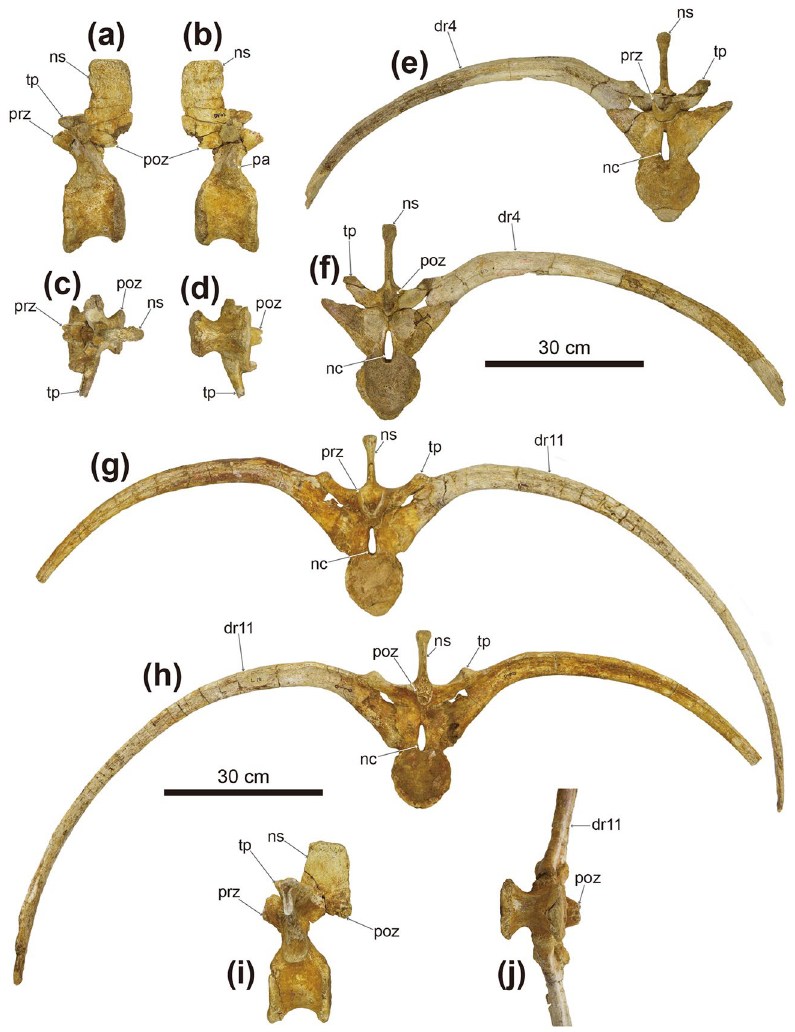
Figure 4. Photographs of dorsal vertebrae of Tarchia tumanovae sp. nov. (MPC-D 100/1353). The fourth dorsal vertebra in ( a ) left lateral, ( b ) right lateral, ( c ) dorsal, and ( d ) ventral views. Fourth dorsal vertebra with fused right rib in ( e ) anterior and ( f ) posterior views. The eleventh dorsal vertebra in ( g ) anterior, ( h ) posterior, ( i ) left lateral (with no ribs attached), and ( j ) ventral views. dr dorsal rib, nc neural canal, ns neural spine, pa parapophysis; prezygapophysis, poz postzygapophysis, tp transverse